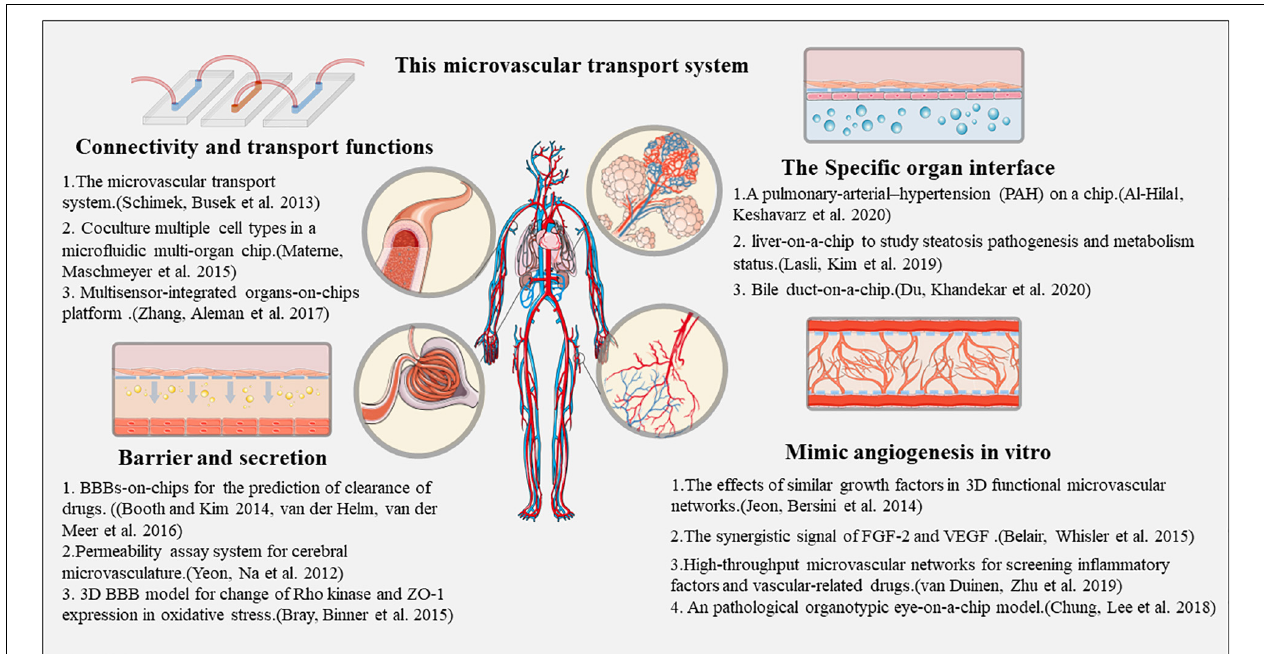
FIGURE 2 | The major mimic strategies of vessels on a